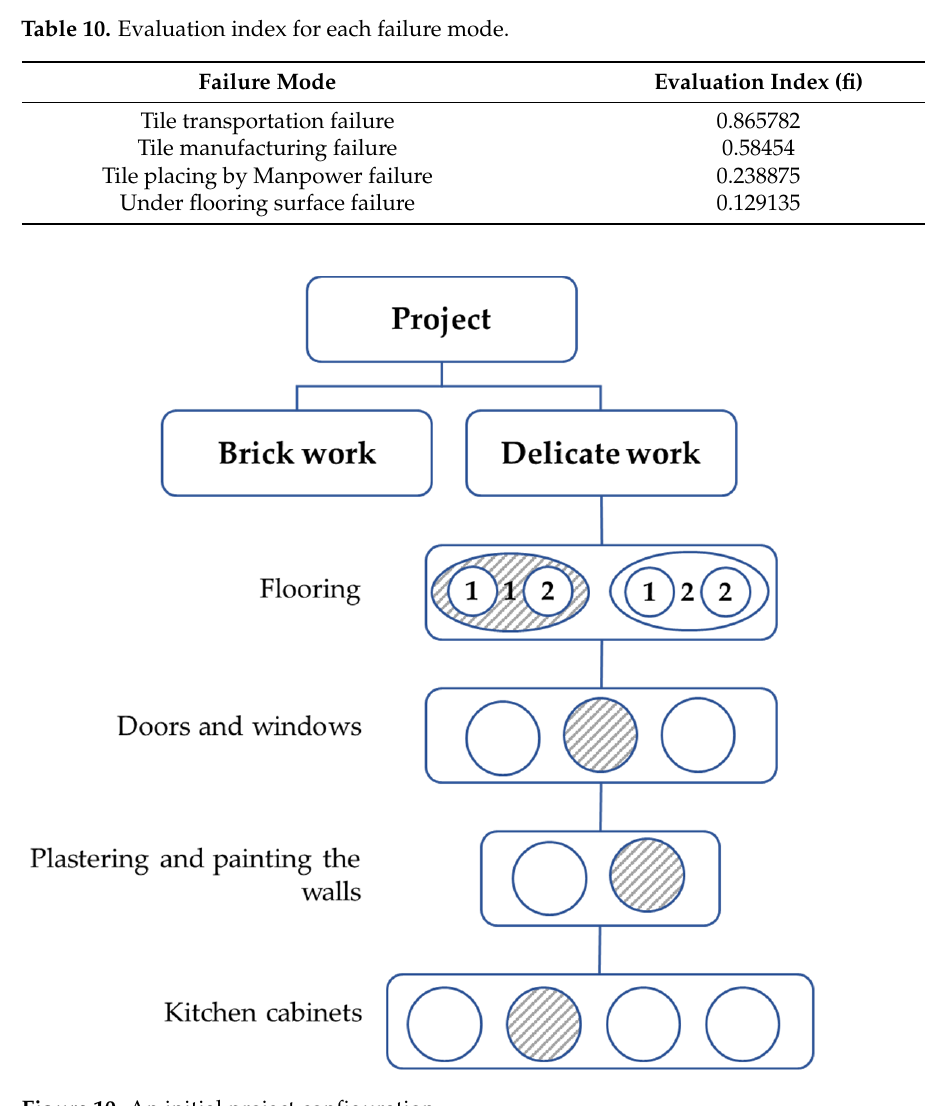
Table 11. Data for two suppliers of Tile.